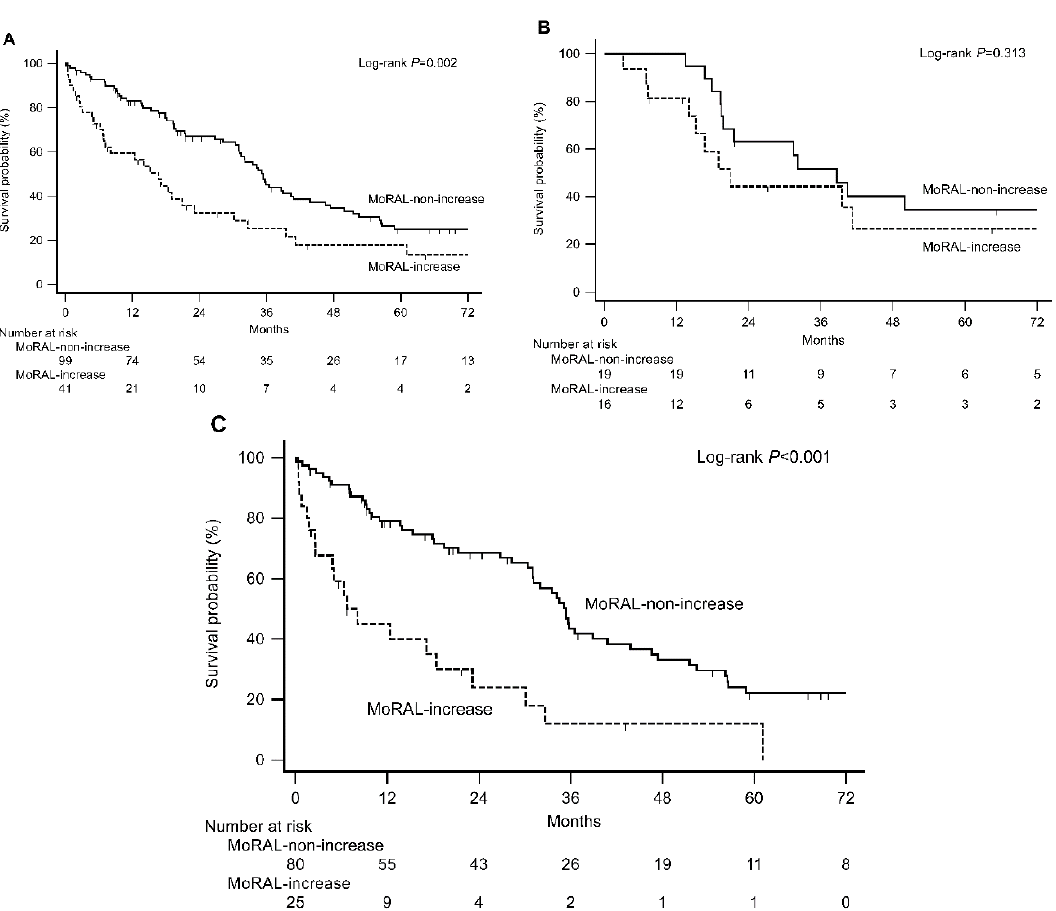
Table 4. Comparison between ΔMoRAL and other models for predicting overall survival.